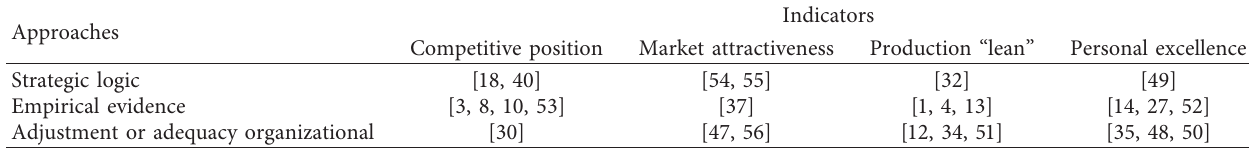
Note: strategic logic: statistical models for analysis of strategic results. Empirical evidence: strategic regulations to indicate better strategic solutions. Adjustment or adequacy organizational: alternatives (organizational design, human resources policy, management style, and organizational culture) for adjustment and strategic